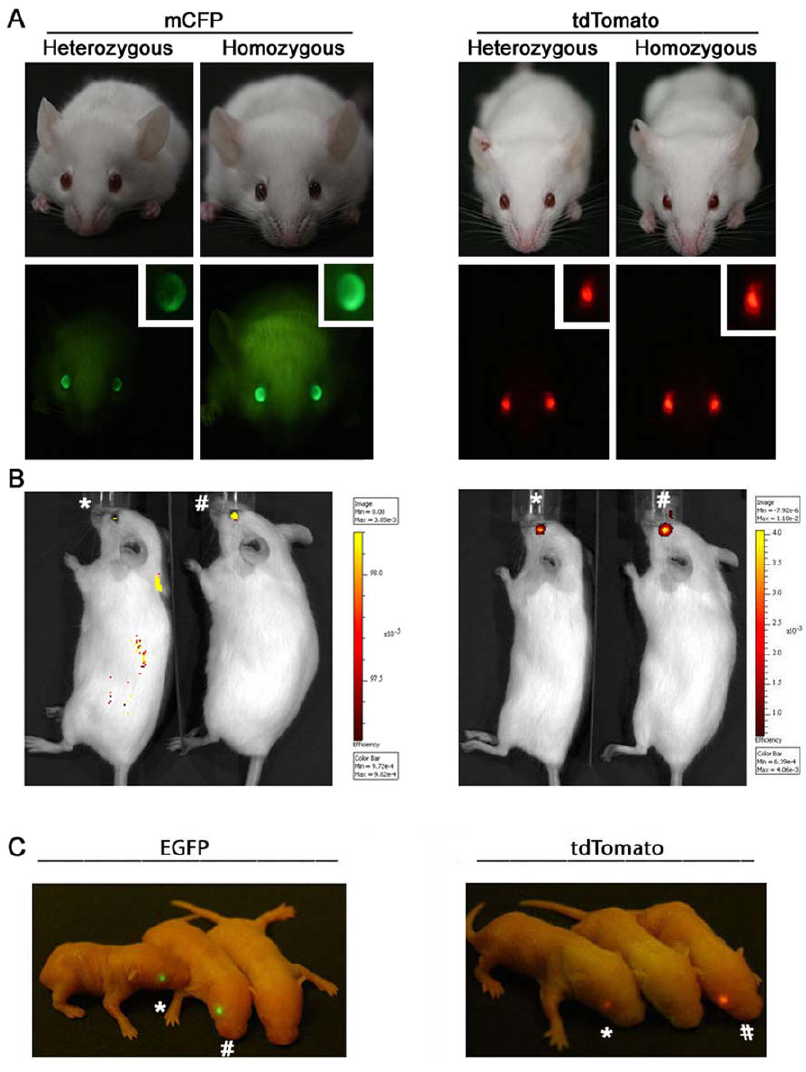
Figure 4. The intensity of the fluorescent eye markers allows differentiation of heterozygous from homozygous transgenic mice. (A) Heterozygous and homozygous adult mice carrying mCFP or tdTomato markers can be easily identified under a handheld flashlight. (B) Homozygosity in adult mice can also be determined more quantitatively using whole animal in vivo fluorescence imaging. (C) Neonatal mice carrying EGFP or tdTomato markers can also be easily identified as heterozygous or homozygous under a handheld flashlight. (* marks heterozygous animals, # marks homozygous animals)